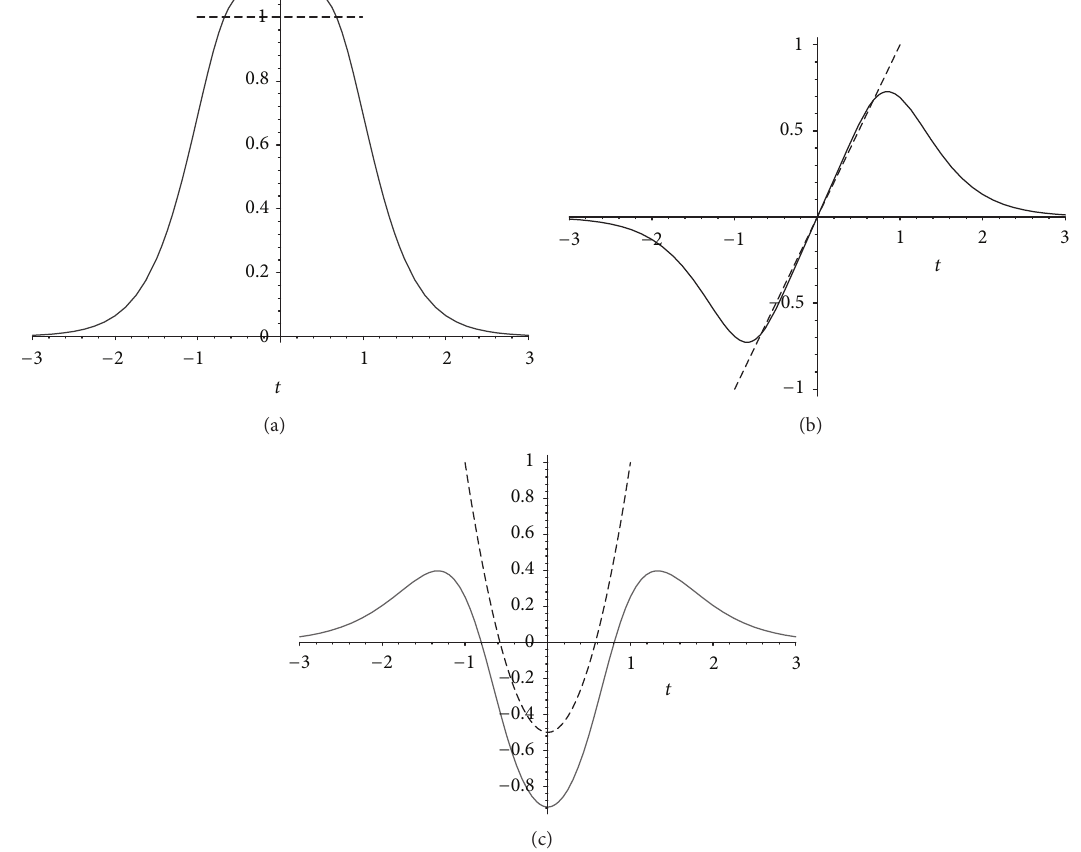
̃𝑃 (𝑞;𝜔) is shown in solid for 𝑞 = 1.20 and is compared with 𝑃 0